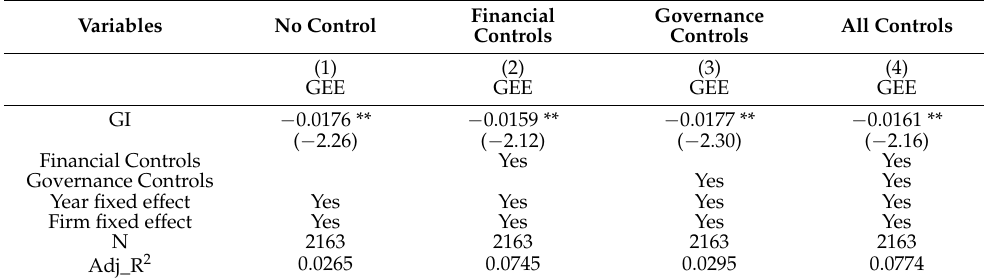
Table 2. Green innovation and green economic efficiency.